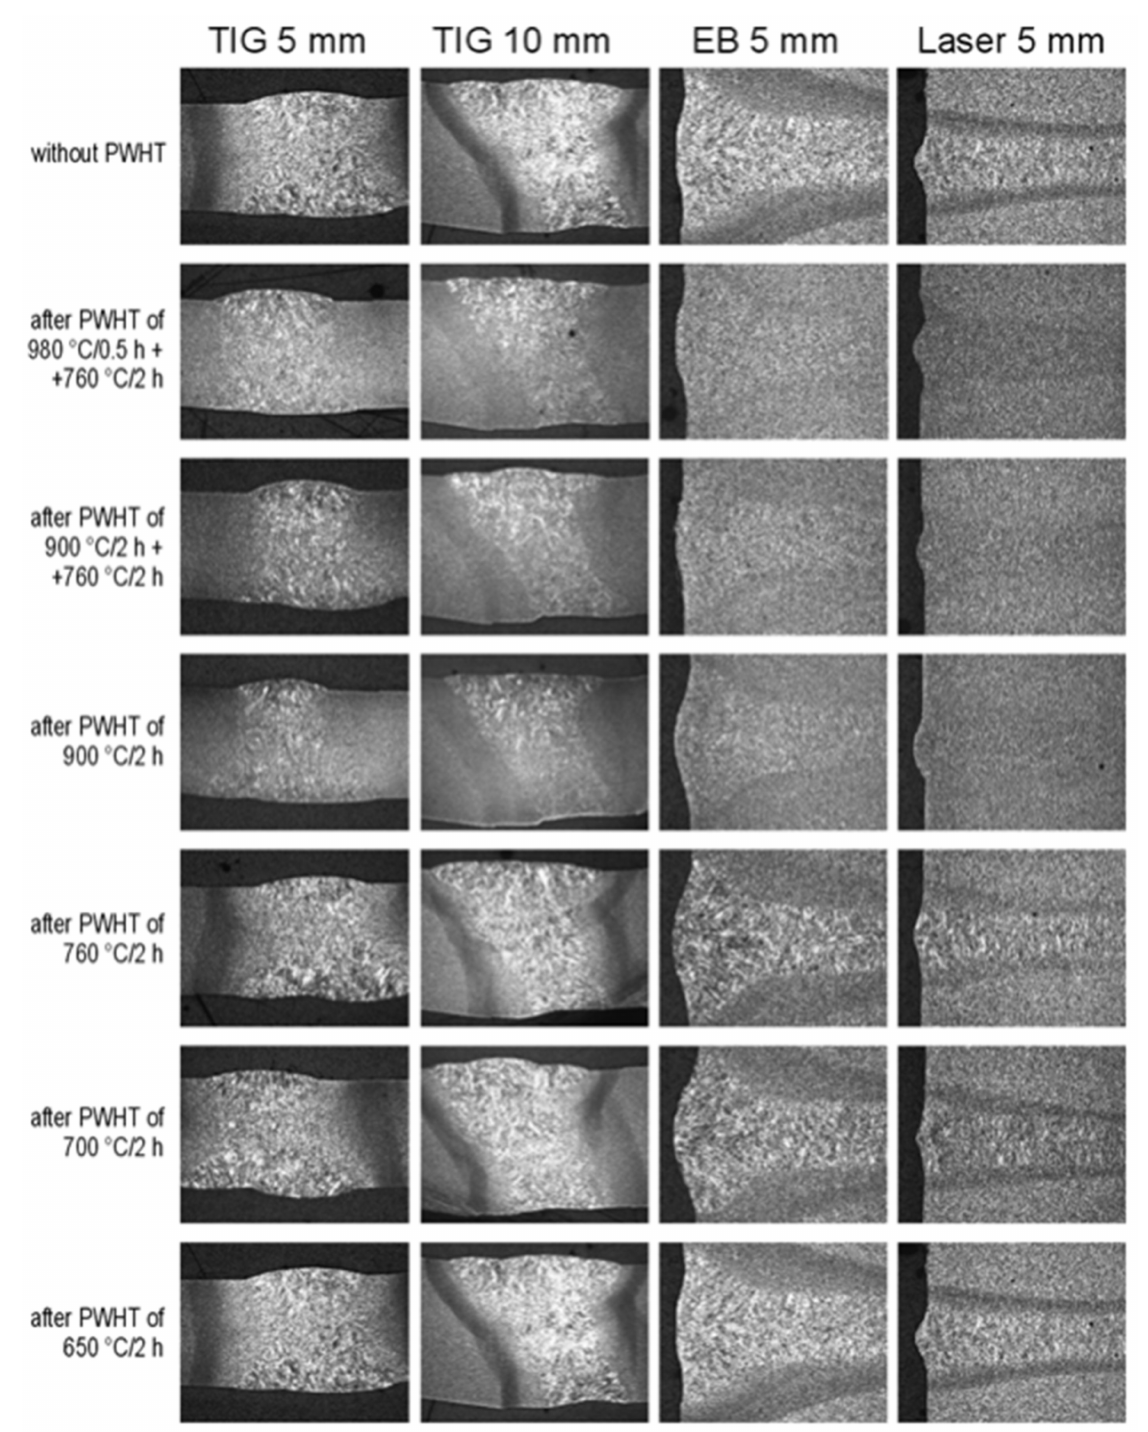
Figure 13. Microstructure of the welds without and after different PWHTs according to Table